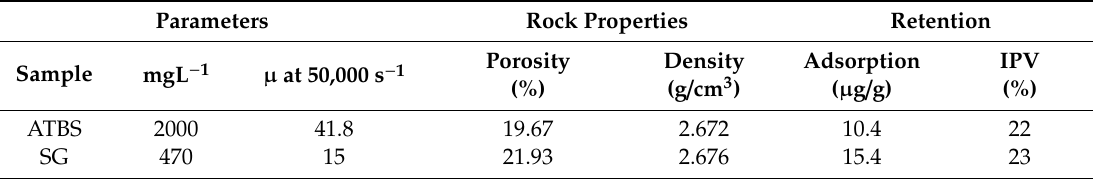
Table 2. Adsorption and inaccessible porous volume (IPV) of Scleroglucan (SG) and sulfonated polyacrylamide (ATBS) at Sorw